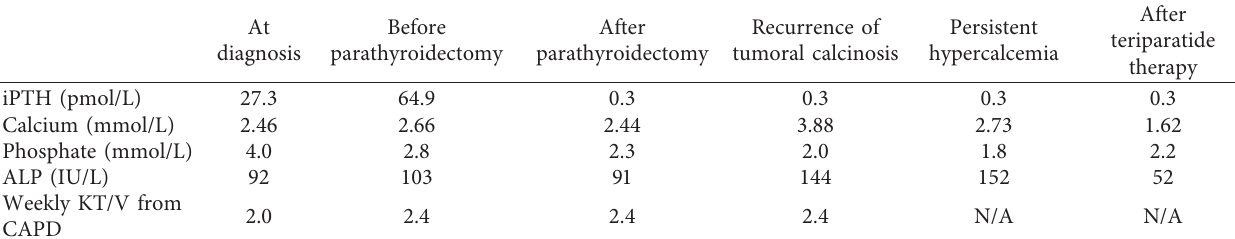
Table 1: Medications and biochemical values at different time points.